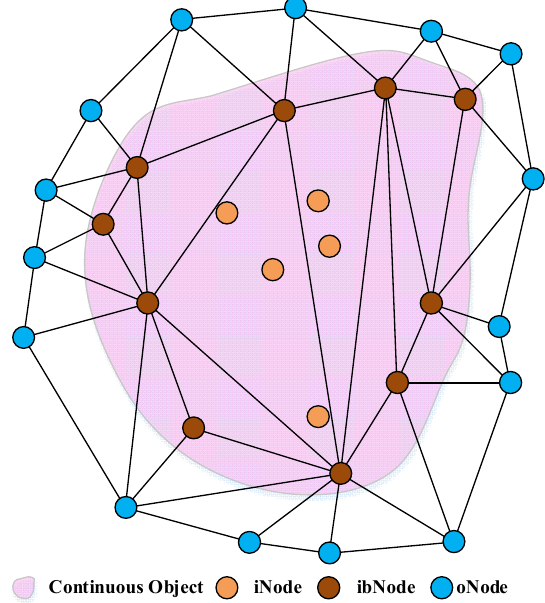
Figure 1. The continuous object’s rough area is sketched by MDT. This rough area is figured out by the deployed sensors using their original locations instead of their adjusted locations. The sensors enclosed within the coverage area of the continuous object are iNodes, and those uncovered are oNodes. The nodes in both sets, iNodes and oNodes , closing to the practice boundary of the continuous object, are picked as the vertices in the plane graph to create the Delaunay triangulation.